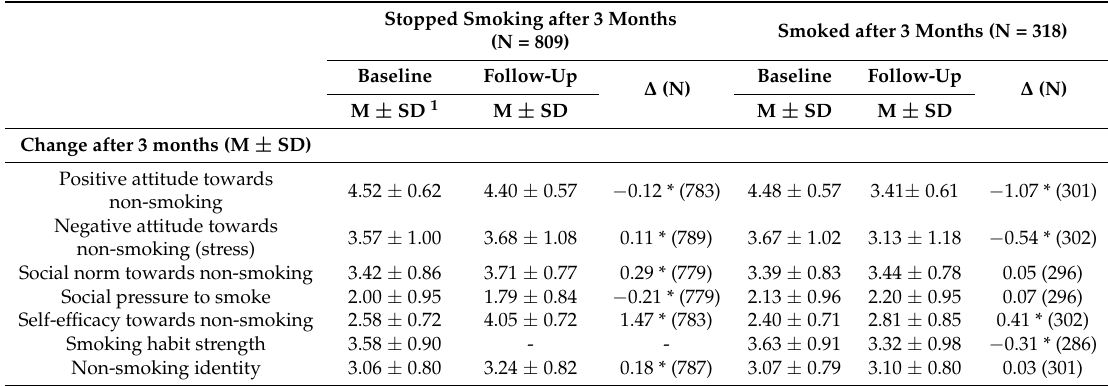
Table 4. Changes in score on Likert scales (1–5) of behavioral determinants for participants who stopped and did not stop smoking after three